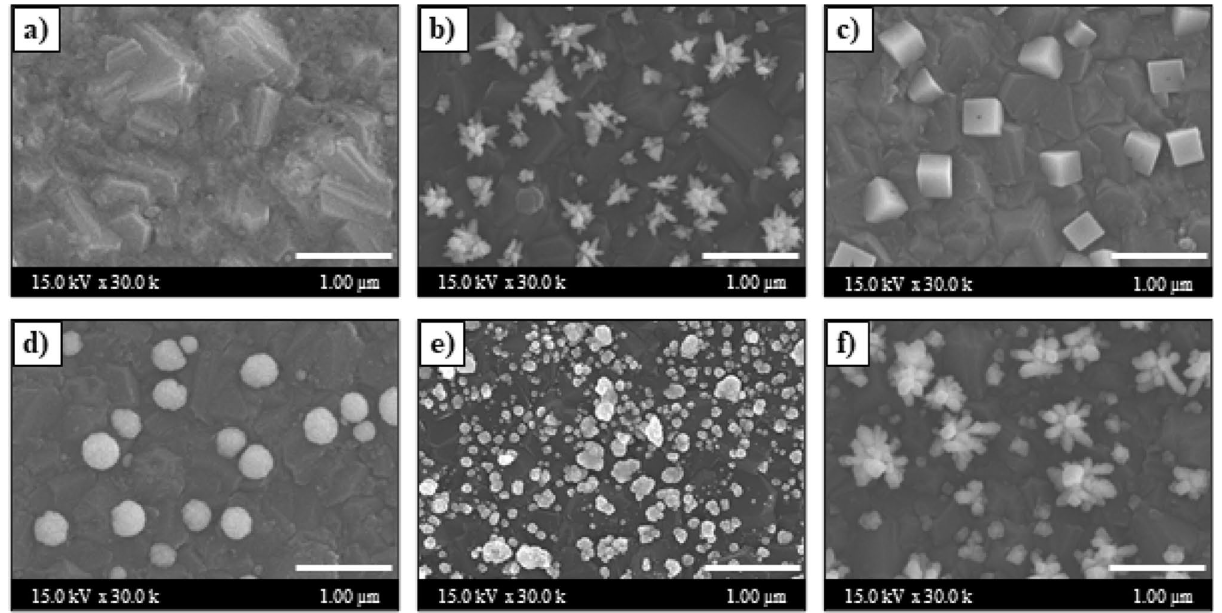
Figure 2. SEM images with ×30,000 magnification of ( a ) BDD, ( b ) Pt/BDD, ( c ) Cu/BDD, ( d ) PtCu/BDD, ( e ) Pt/Cu/BDD, and ( f ) Cu/Pt/BDD electrodes prepared via multiple-step deposition